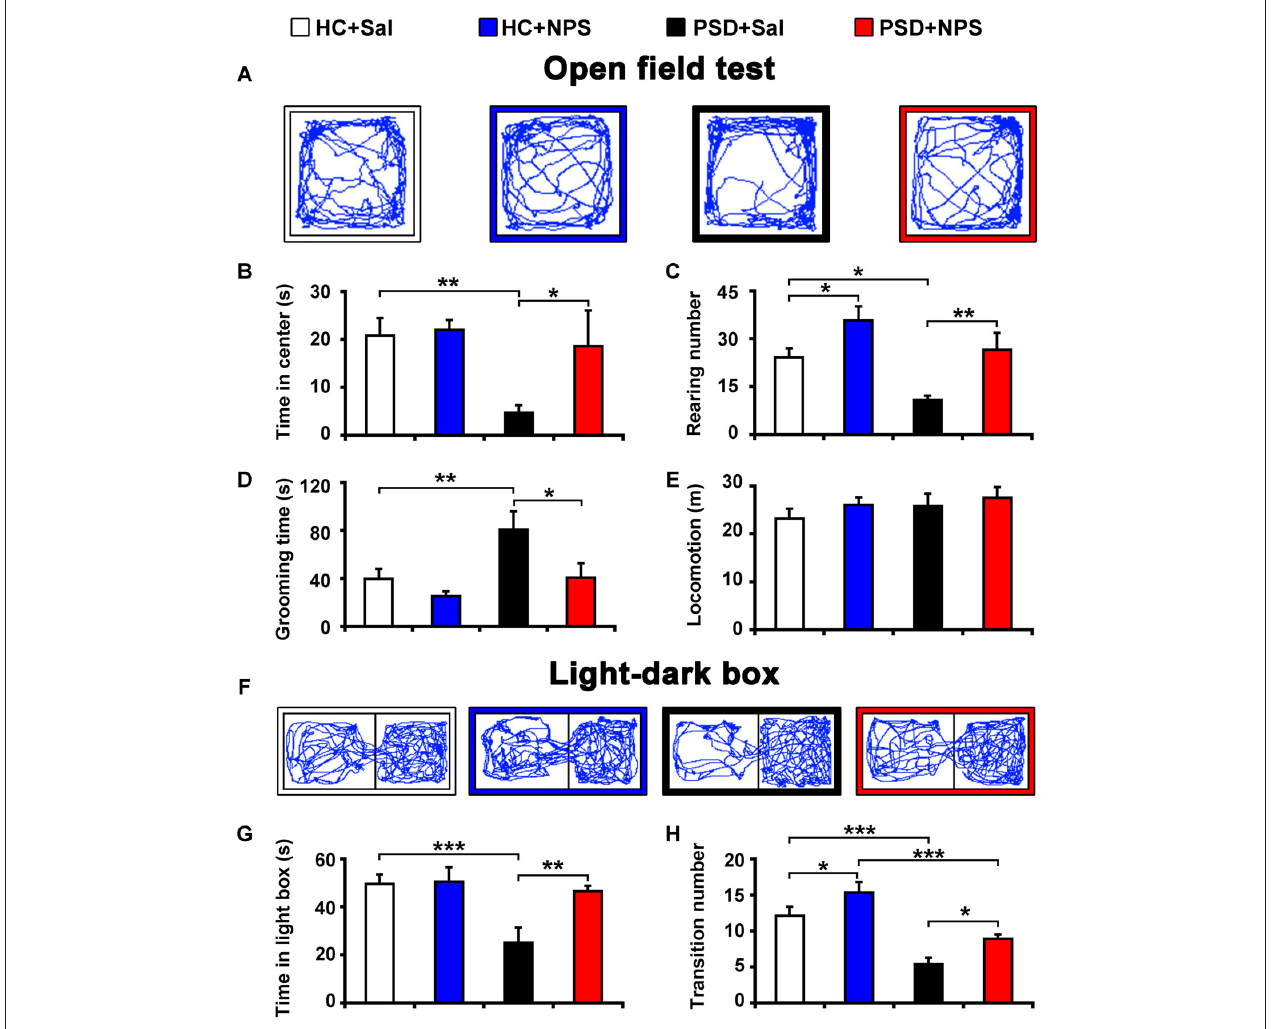
FIGURE 2 | Central administration of NPS attenuated PSD-induced anxiety-like behaviors. After 24-h PSD, rats were subjected to open field test (OFT) (A–E) and light-dark box (LDB) (F–H) anxiety tests. NPS or saline (Sal) i.c.v. injection was carried out 5 min before tests. Representative locomotor paths in OFT (A) and LDB (F) of home cage control rats given saline (HC + Sal) or NPS (HC + NPS), and PSD rats given saline (PSD + Sal) or NPS (PSD + NPS) are respectively shown. PSD decreased the time spent in center zone (B) and rearing number (C) , but increased the time spent in grooming (D) in OFT. PSD also decreased the time spent in light box (G) and transition number (F,H) in LDB. NPS abolished all the changes caused by PSD (A–D,F–H) . There was no significant difference in locomotion in the OFT among four groups (E) . Values are means ± SEM ( n = 9–12). ∗ P < 0.05, ∗∗ P < 0.01, ∗∗∗ P < 0.001. Data were analyzed by two-way analyses of variance